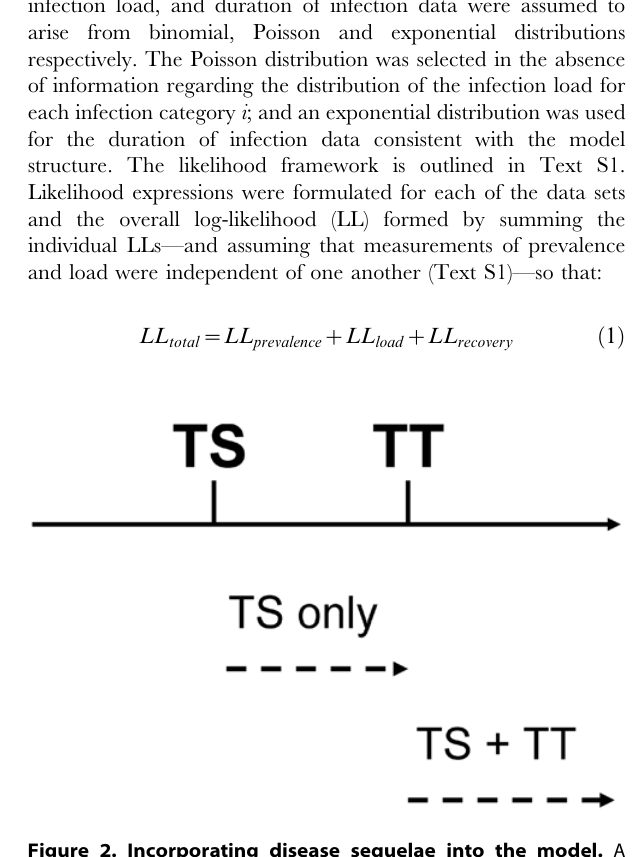
Figure 2. Incorporating disease sequelae into the model. A schematic representation of the way in which the model determines the presence of disease sequelae: trachomatous scarring (TS) and trachomatous trichiasis (TT) (TS and TT—but not corneal opacity, CO— are considered to be caused exclusively by reinfection with C. trachomatis ). The simplest scheme is used: thresholds exist, along the ladder of infection, beyond which each of the sequelae are assumed to be present. Beyond the threshold corresponding to a specific sequela, that sequela is assumed to be observed, e.g. when the threshold for TT has been reached, both TT and TS are observed.